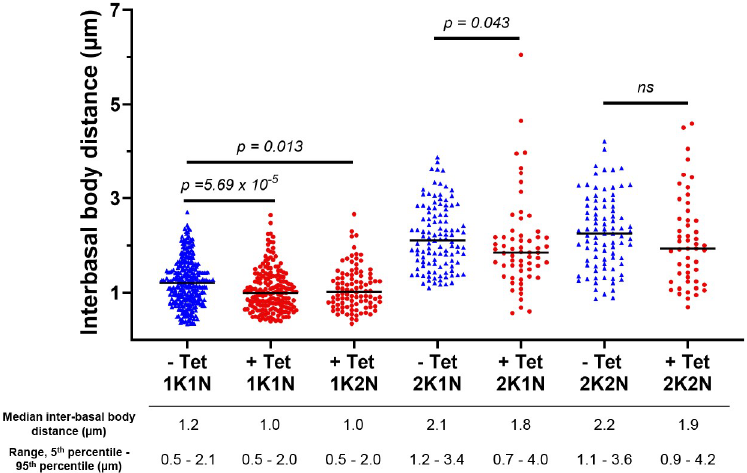
Fig 5. Basal body separation after knockdown of TbCK1.2. Knockdown of TbCK1.2 was induced with tetracycline (1 µ g/mL for 24 h), and the distance between mature basal body pairs was measured. Antibody against TbRP2 (YL1/2) was used to identify basal bodies. ImageJ was used to measure inter-basal body distances (distance between two YL1/2 + mBBs) in TbCK1.2 RNAi cells cultured in the absence (-Tet) or presence of tetracycline (+Tet). A Mann-Whitney U test was used to determine whether differences in inter-basal body distances in control and TbCK1.2 RNAi cells were statistically significant; p values are noted on the graph. Data presented is an aggregate from six biological replicates (n = 302 (-Tet 1K1N), 183 (+Tet 1K1N), 96 (+Tet 1K2N), 111 (-Tet 2K1N), 61 (+Tet 2K1N), 88 (-Tet 2K2N), 51 (+Tet 2K2N)). Descriptive statistics are provided beneath the corresponding data on each graph.